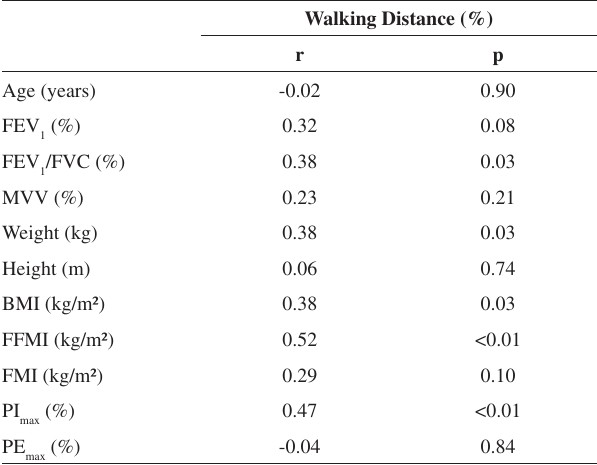
Table 2 - Pearson correlation between walking distance (%) and age, spirometry, body composition and respiratory muscle